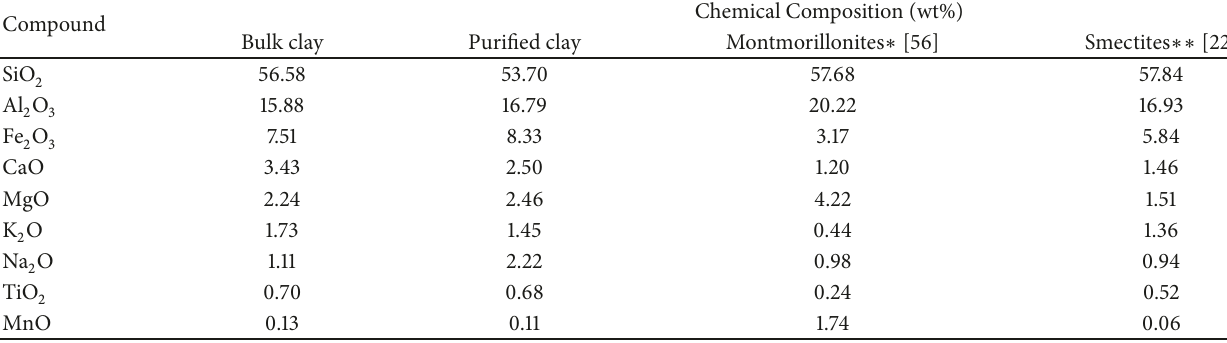
Table 2: Chemical composition of the bulk and purified clay used in this study compared with literature data and previous studies. Compound